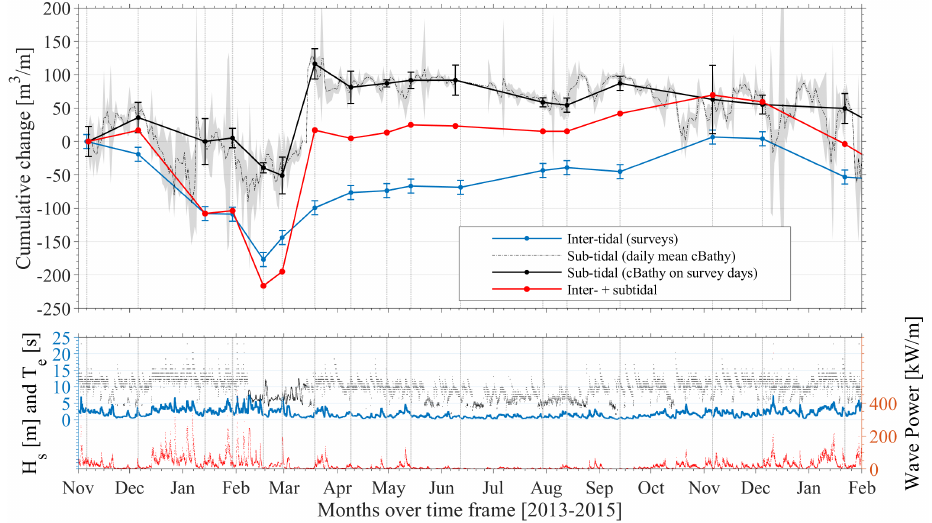
Figure 9. The upper panel shows cumulative volume change on every survey-date since the start 6 November 2013 for the inter-tidal beach (blue), the sub-tidal area (grey and black) and the sum of both (red). The bottom plot presents hourly incident wave conditions over the same time-frame wherein the blue line indicates H s , the black dots the energy period and the red dots correspond to the incident wave power per meter wave crest length. The error bars represent the daily standard deviation for the bathymetry estimates (black) and for the inter-tidal beach (blue) we presume that the RTK-GPS is reasonably 0.05 m accurate in the